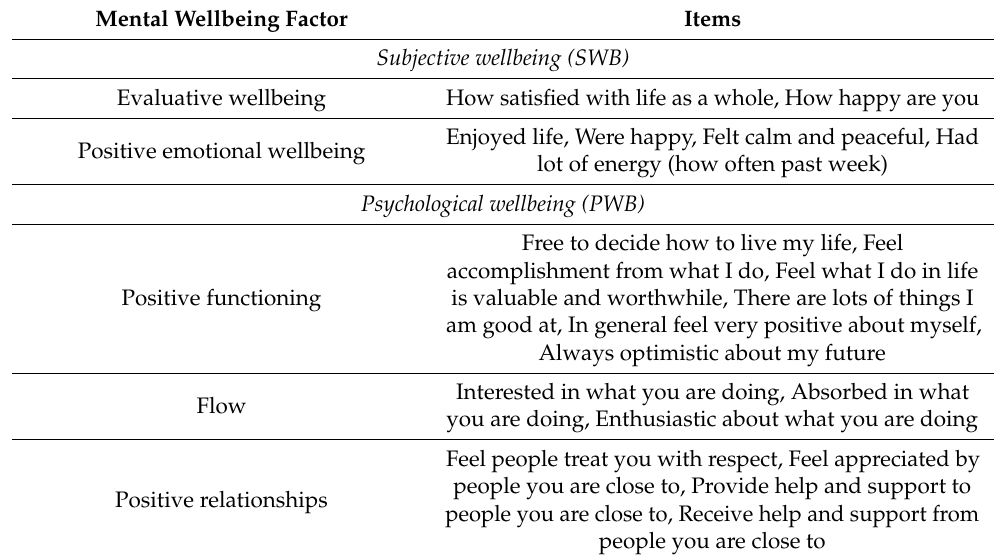
Table A3. Items included in the calculation of mental wellbeing measures a